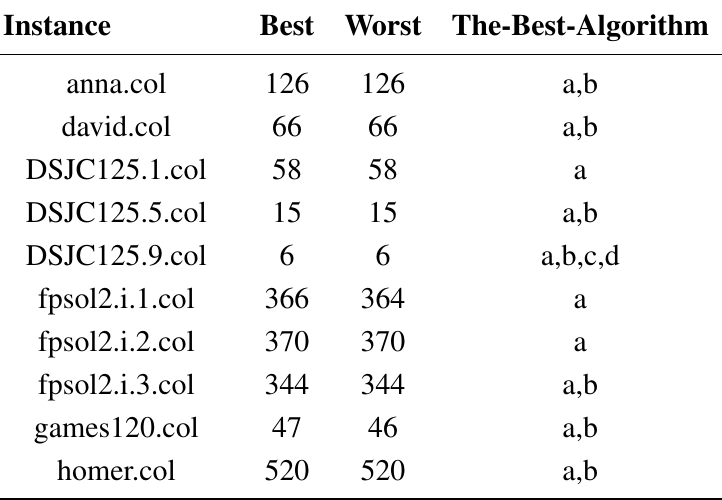
Table 8. Results for algorithm